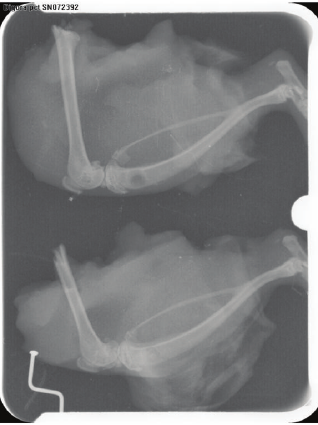
Figure 2: Radiographic view on day 7. A: Left tibia. B: Right tibia.